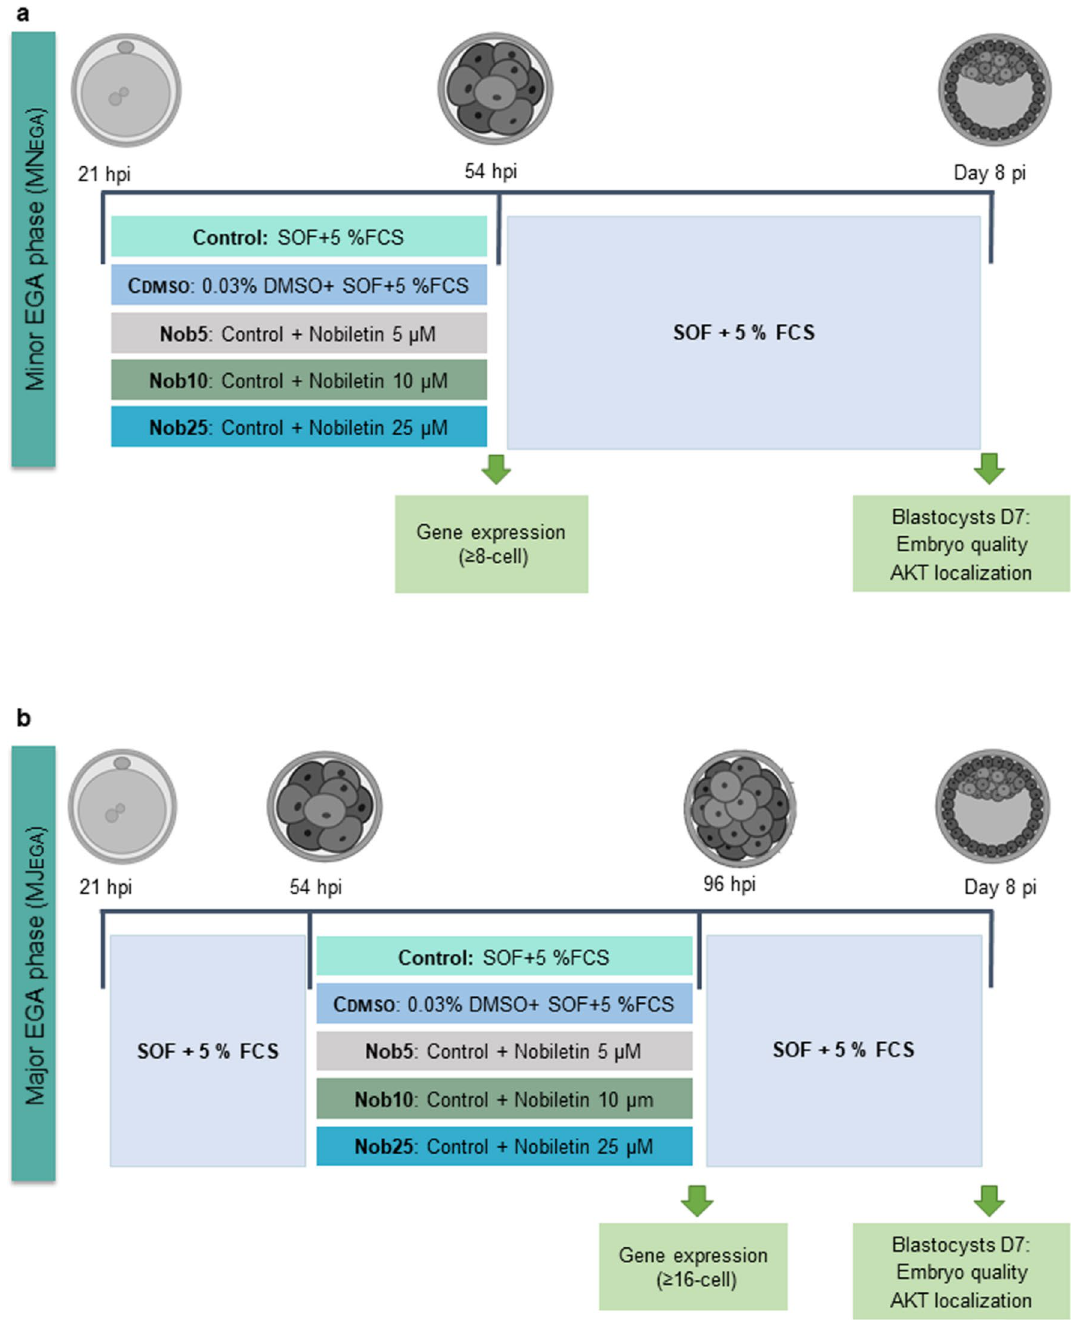
Figure 9. Experimental design. ( a ) MN EGA : Presumptive zygotes were cultured during the minor EGA phase (2- to 8-cell stage: 21–54 hpi) in synthetic oviductal fluid (SOF) with 5% fetal calf serum (FCS) (Control); supplemented or not with 5, 10 and 25 µM nobiletin (Nob5, Nob10 and Nob25, respectively), or with 0.03% dimethyl sulfoxide [control for DMSO vehicle for nobiletin dilution (C DMSO )]. At 54 hpi, embryos that reached the 8-cell stage were transferred to SOF + 5% FCS and cultured until Day 8 maintaining each experimental group separately. ( b ) MJ EGA : Presumptive zygotes were cultured in SOF + 5% FCS (Control) until 54 hpi. At 54 hpi, embryos that reached the 8-cell stage were cultured during the major EGA phase (8-cell to 16-cell stage: 54–96 hpi) in SOF + 5% FCS supplemented or not with Nob5, Nob10 and Nob25, or with 0.03% dimethyl sulfoxide (C DMSO ). At 96 hpi, embryos that reached the 16-cell stage were transferred to SOF + 5% FCS and cultured until Day 8 maintaining each experimental group